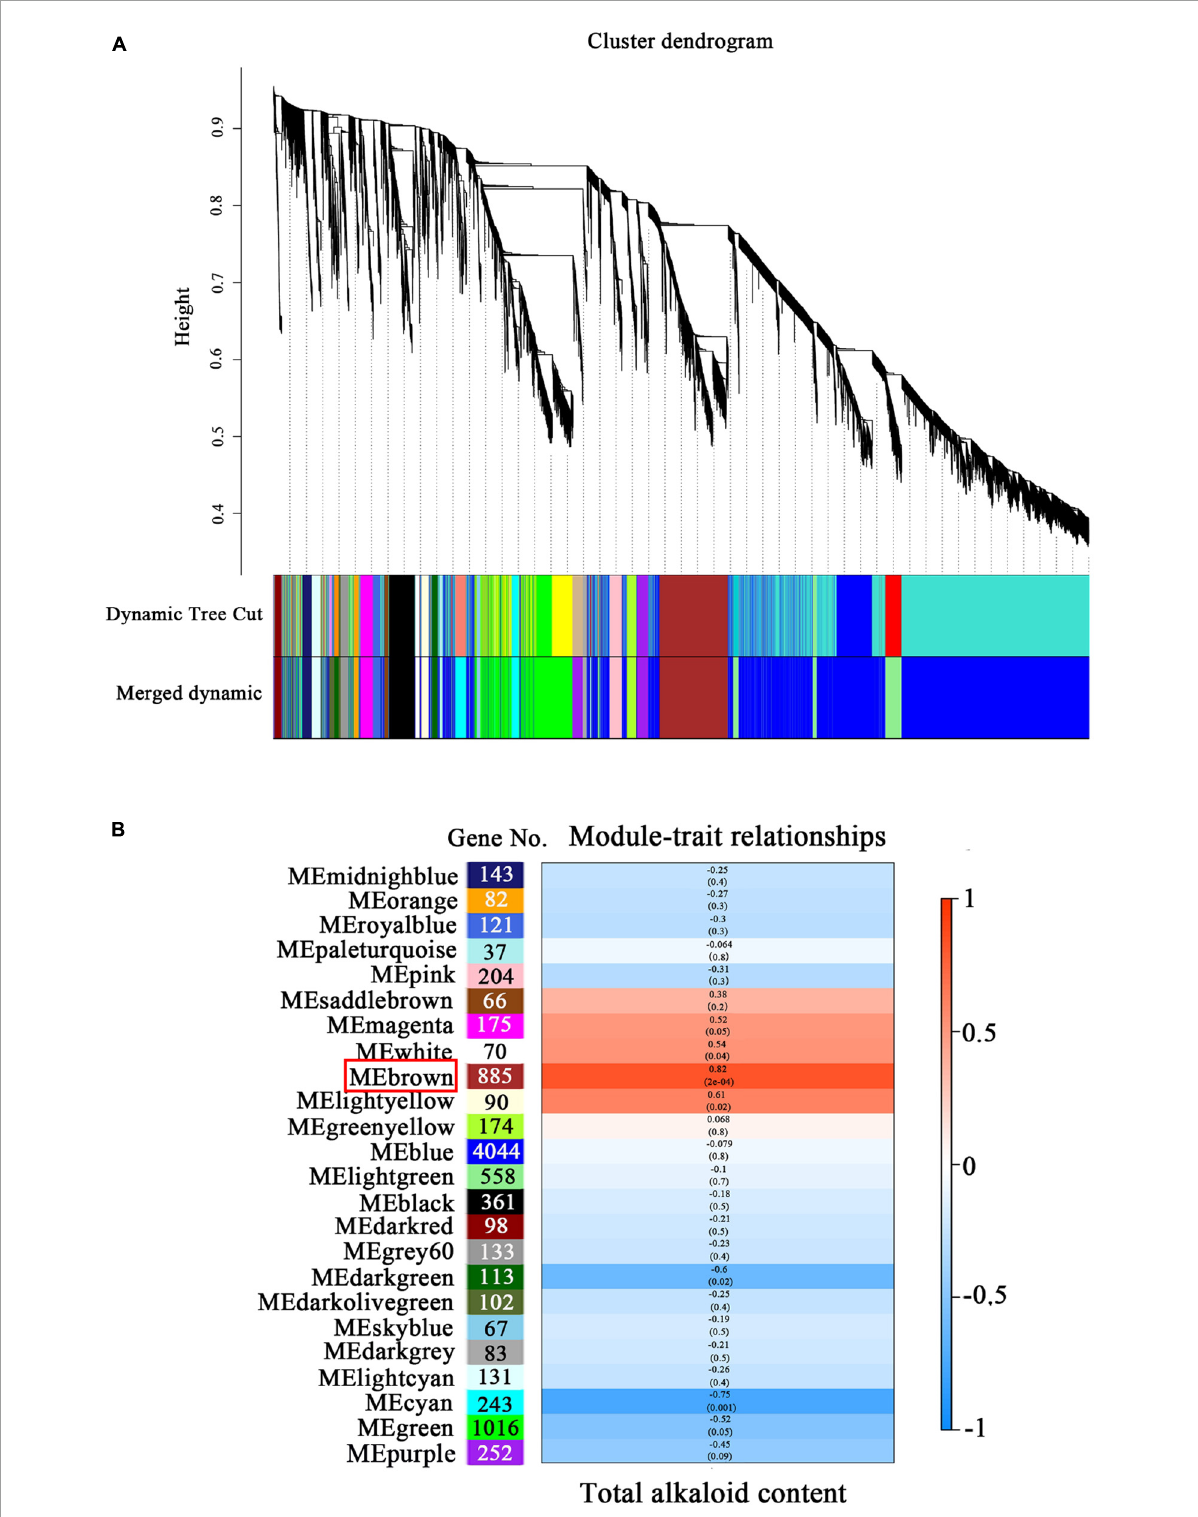
FIGURE6 Weighted gene coexpression network analysis (WGCNA) and modules related to alkaloid biosynthesis in D. officinale PLBs. (A) Dendrogram with color annotation. (B) Pearson correlation coefficient ( r ) and the p -value for alkaloid content and each module. The color scale on the right shows module-trait correlation from − 1 (blue) to 1